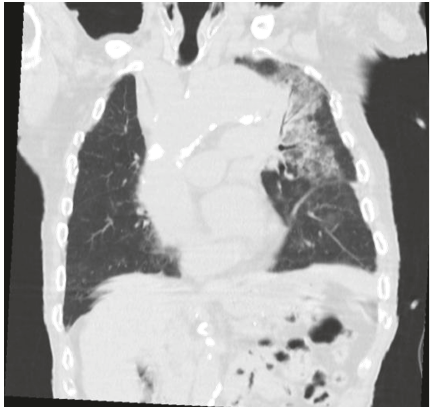
Figure 4: Coronal view aortic aneurysm eroding into the left upper